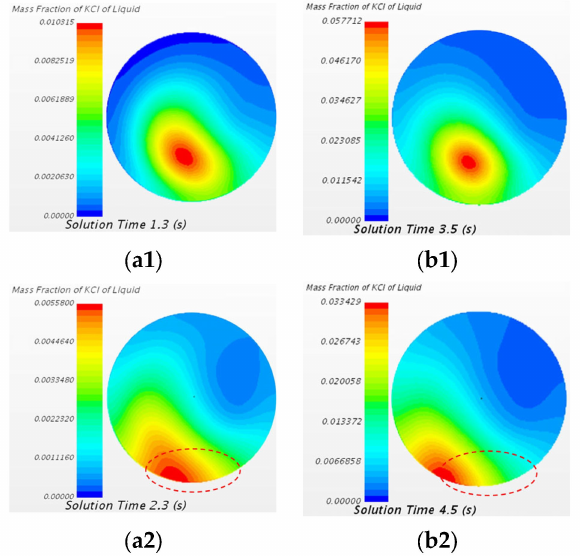
Figure 12. Comparison of mass fraction of the KCl tracer of the case of the 20 mL KCl tracer and the case of the 150 mL KCl tracer at the A3–A3 cross section at different states. ( a1 ) 20 mL 1.3 s,